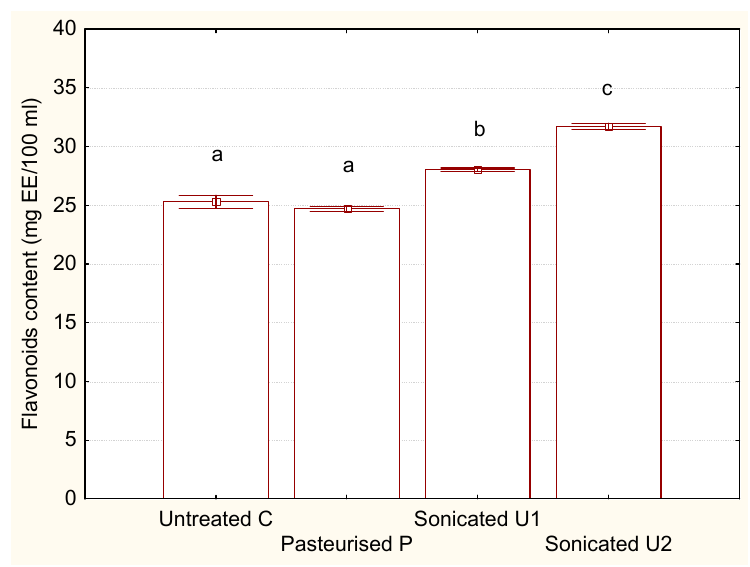
Figure 4. Effect of preservation method on flavonoid content in apple juice. Error bars represent standard deviations. Values that share the same letter are not significantly different at P < 0.05.